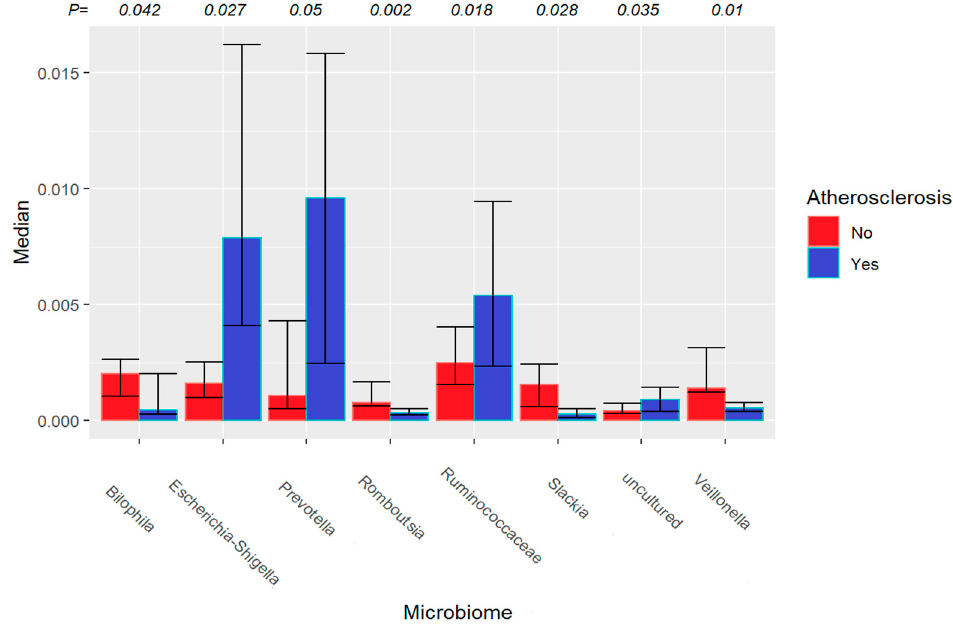
Figure 18. The candidate microbes at the genus taxonomic level without correction in the two groups.